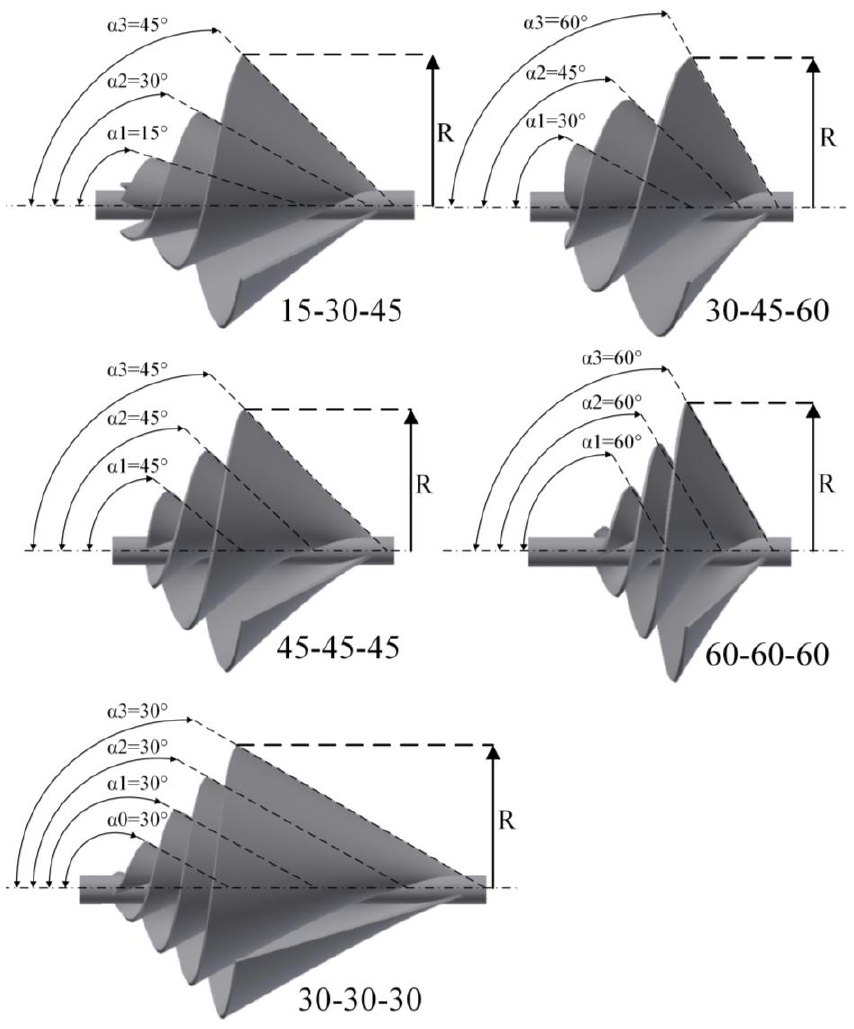
Figure 4. Schematic view of the five ASWT rotors.